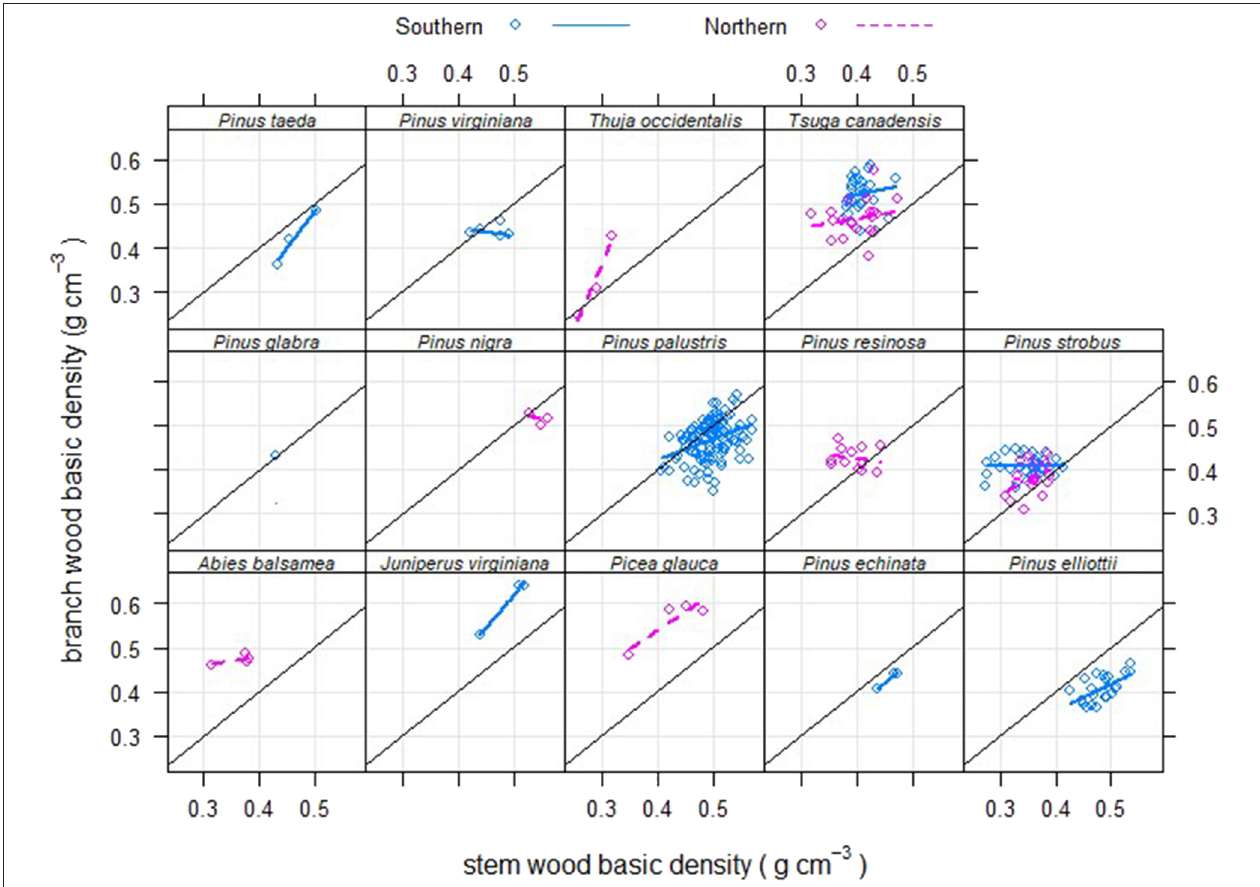
FIGURE 8 | Branch wood – stem wood basic density relationships for North American trees (circles) of different evergreen gymnosperm species that were sampled in either the northern or southern data sets used in this study, or